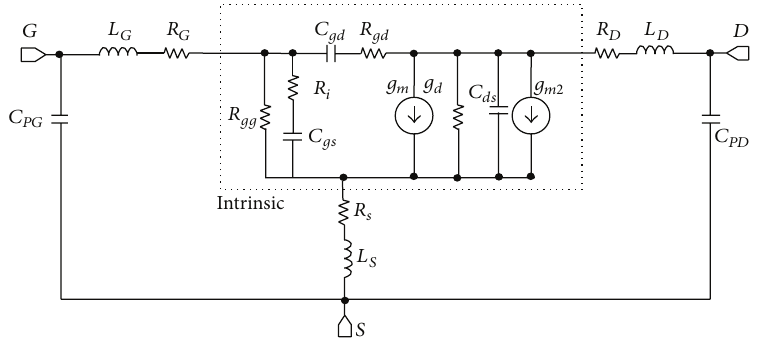
Figure 6: Small-signal equivalent circuit tacking into account gate leakage current ( 𝑅 𝑔𝑔 ) and impact ionisation ( 𝑔 𝑚2 ).